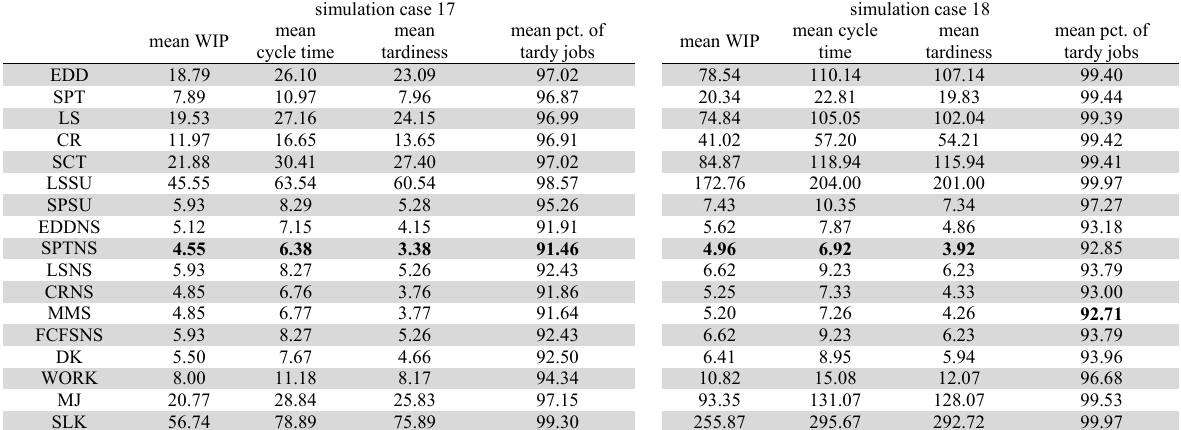
Results for simulation cases 17 and 18. The minimum values for each performance metric and simulation case are denoted in